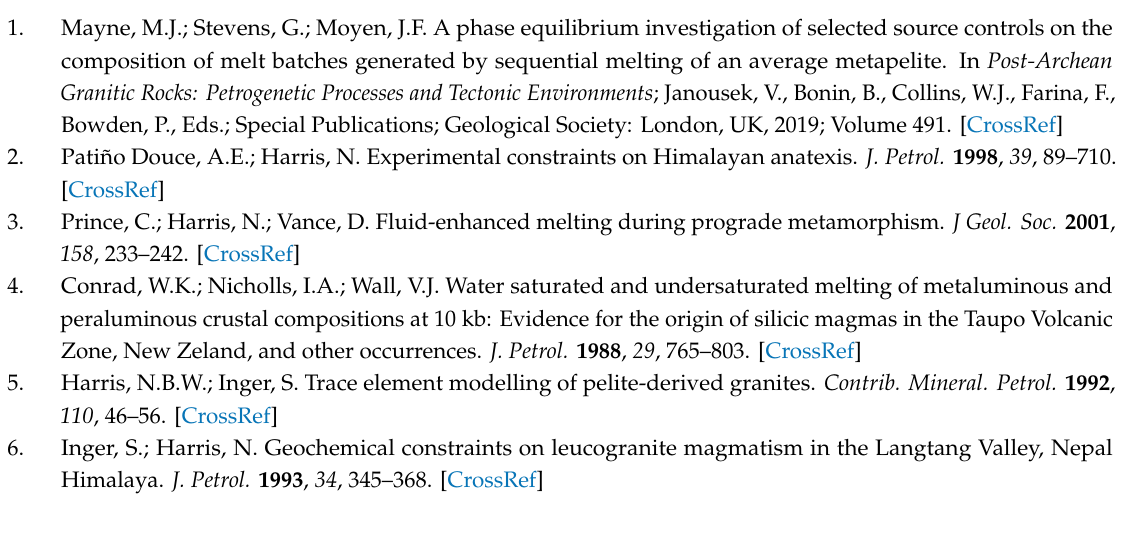
Table S1: Major and trace element composition of migmatites from north-eastern